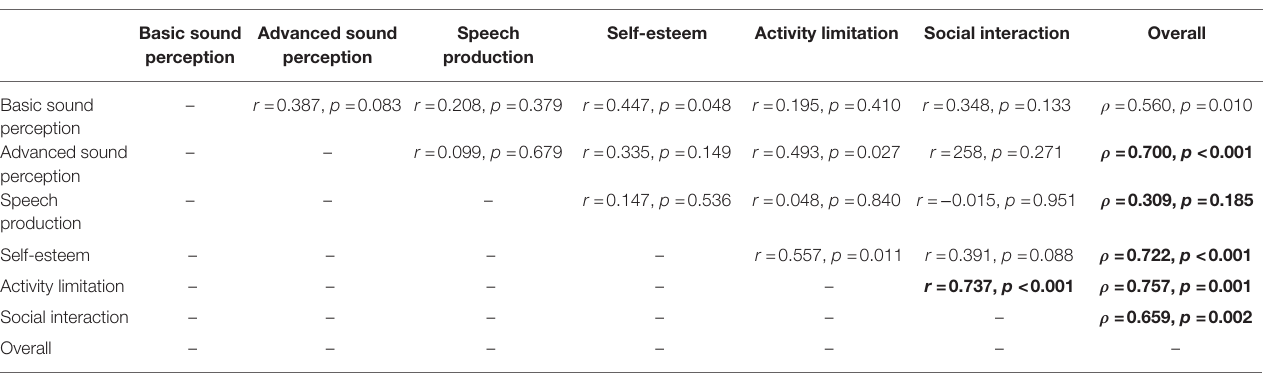
TABLE 2 | Intercorrelations between the NCIQ.